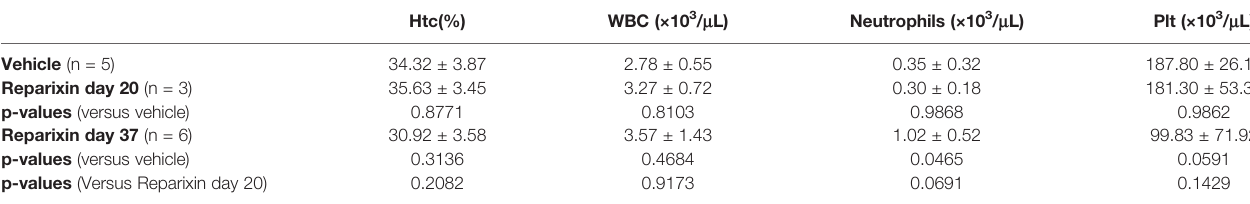
TABLE 1 | Blood parameters observed in mice treated with vehicle or with Reparixin for 20 or 37